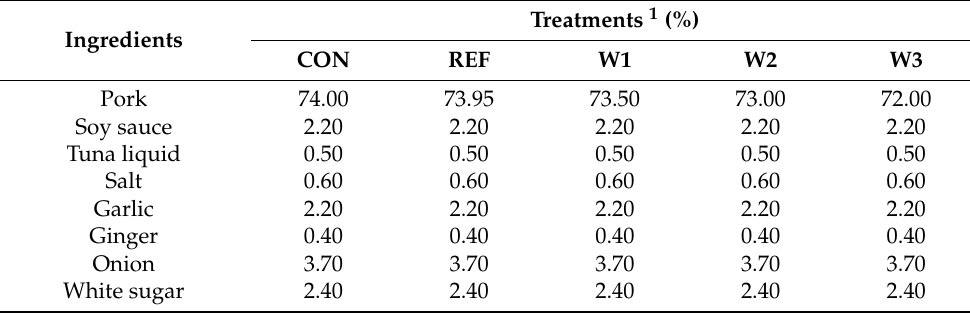
Table 2. Recipes for the indicated treatments of Tteokgalbi with watermelon radish powder.